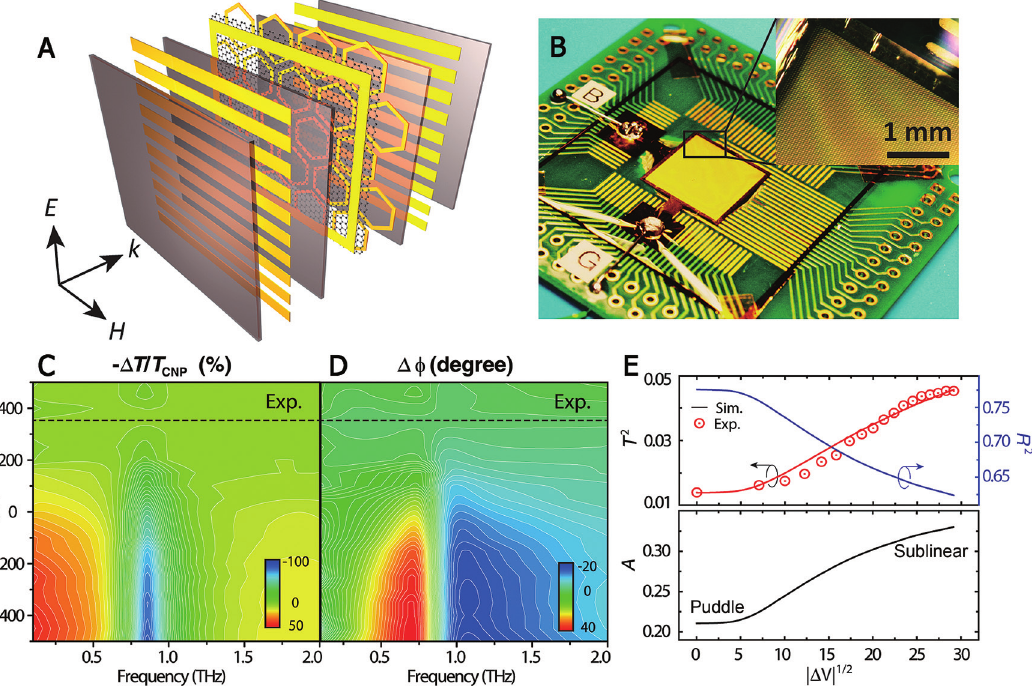
Figure 9 (A) Schematic of a gate-controlled active graphene metamaterial. A single-layer graphene is deposited on a hexagonal metallic meta-atom layer and connected to an electrode (yellow frame) playing the role of ground and then sandwiched by EOT electrodes (yellow strips) embedded in dielectrics. (B) The graphene metamaterial in (A) integrated to a drilled PCB for THz-TDS measurement. The inset shows the magnified view of the planar multilayer structure. Measured spectra of (C) relative change in transmission, and (D) phase change of the hexagonal graphene metamaterials. The dashed line denotes the voltage of the charge neutral point (CNP) V sion ( T 2 ), reflection ( R 2 ), and absorption ( A ) of the graphene metamaterial at the resonance frequency. Figures are adopted from Ref. [141] with